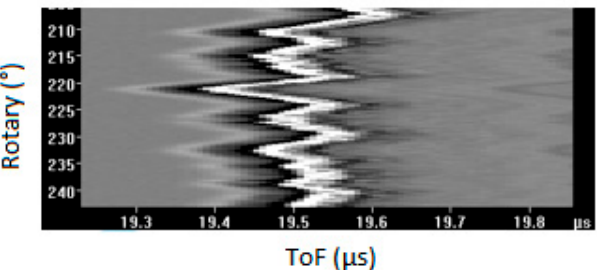
Figure 4. A sample for B-Scan with chatter.